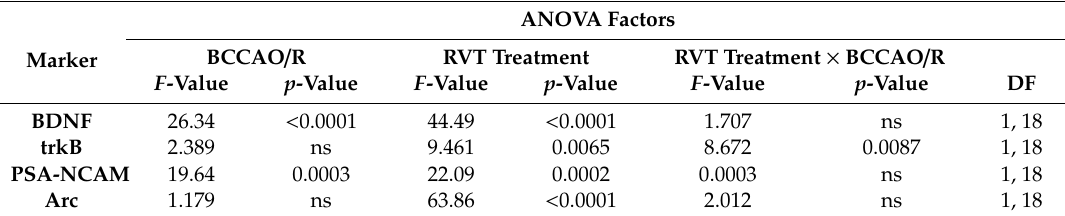
Table 1. F -values and significance levels from two-way ANOVA performed on data obtained after BCCAO / R and resveratrol (RVT) pre-treatment by means of Western blot in the rat frontal cortex. ANOVA Factors BCCAO / R RVT Treatment RVT Treatment × BCCAO / R Marker F -Value p -Value F -Value p -Value F -Value BDNF PSA-NCAM Arc 1.179 ns Arc, activity-regulated cytoskeleton-associated protein; BDNF, brain-derived neurotrophic factor; PSA-NCAM, polysialylated neural cell-adhesion molecule; trkB, tyrosine kinase receptor B. DF, degrees of freedom; ns: not